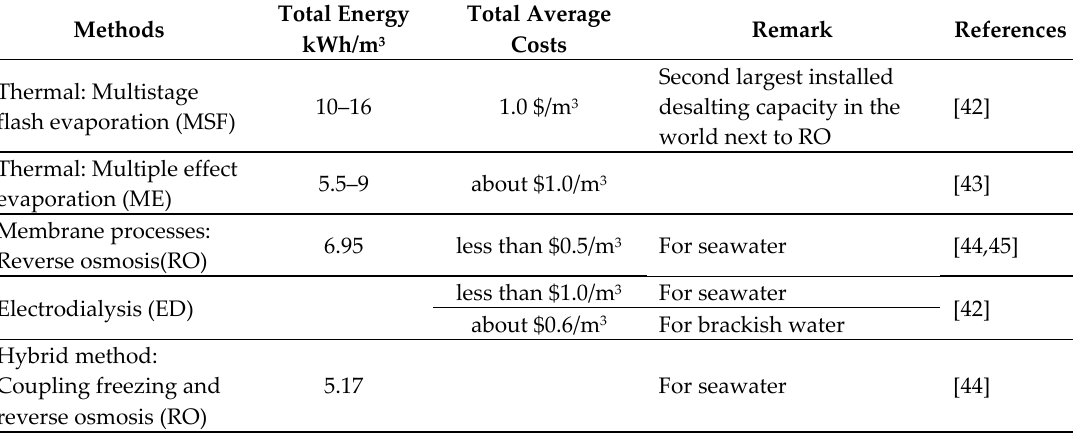
Table 2. Energy consumption and total average costs of large scale commercial desalination